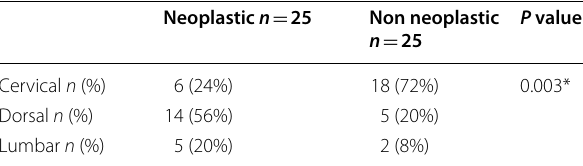
*indicates statistically significant value